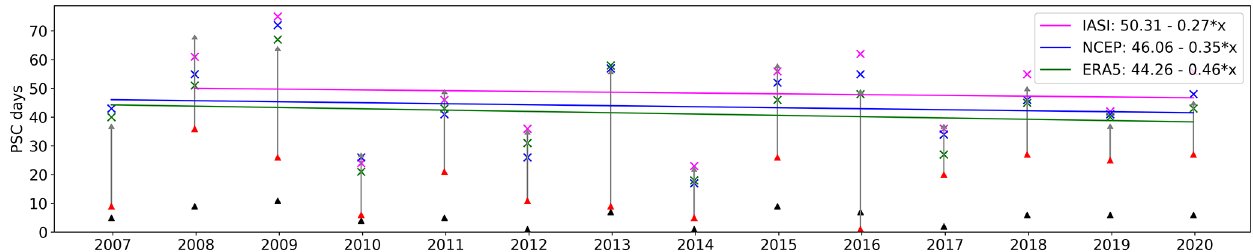
Figure 9. PSC days per year at DDU from 2007 to 2020 featuring PSC detection with the DDU lidar in red triangles and with CALIOP in black triangles. Potential PSC days per year estimated by ERA5, NCEP and IASI based on the lidar measurements are shown with green, blue and fuchsia crosses respectively. Green, blue and fuchsia lines represent the corresponding trends. Grey arrows indicate the number of days per year where the T − T NAT < − 1K criterion was satisfied and the DDU lidar was not